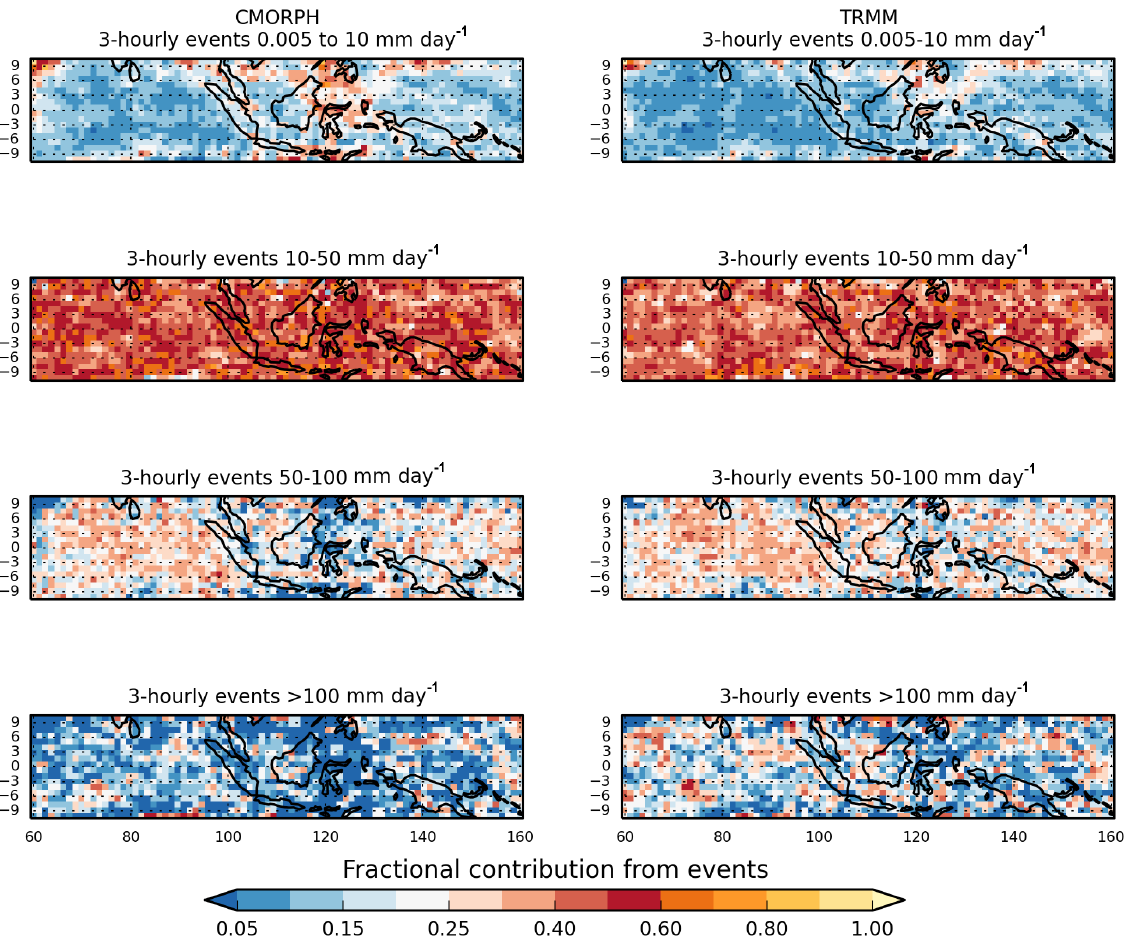
Figure 1. For (left) CMORPH and (right) TRMM 3B42 1.25 ◦ data, the fractional contribution to the total precipitation rate from ranges of intensity bins are shown in the labels above each panel. For each dataset, the sum of each column is unity.